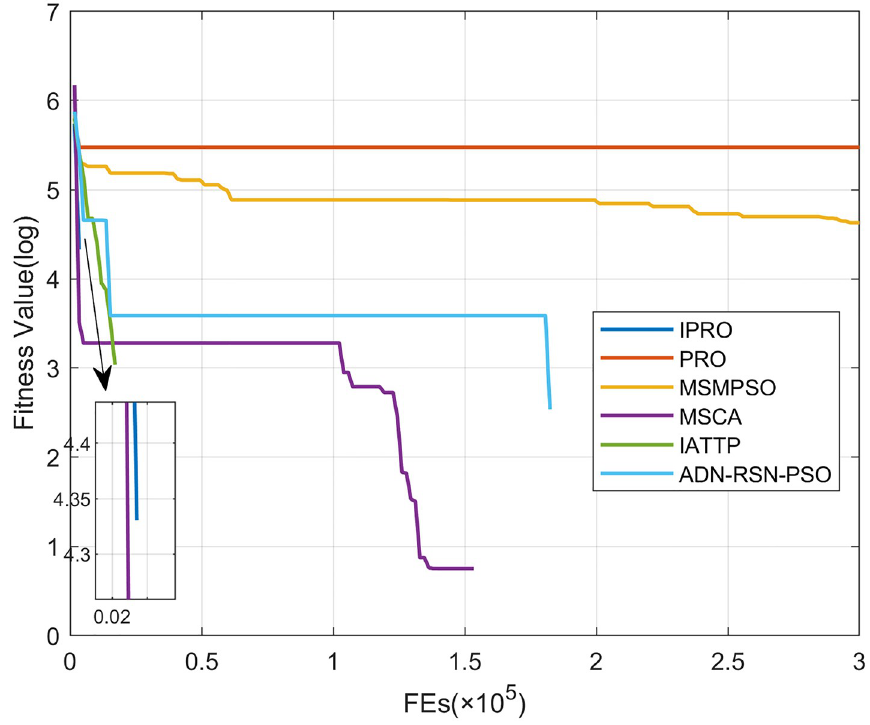
Fig 11. Convergence curves on F11.